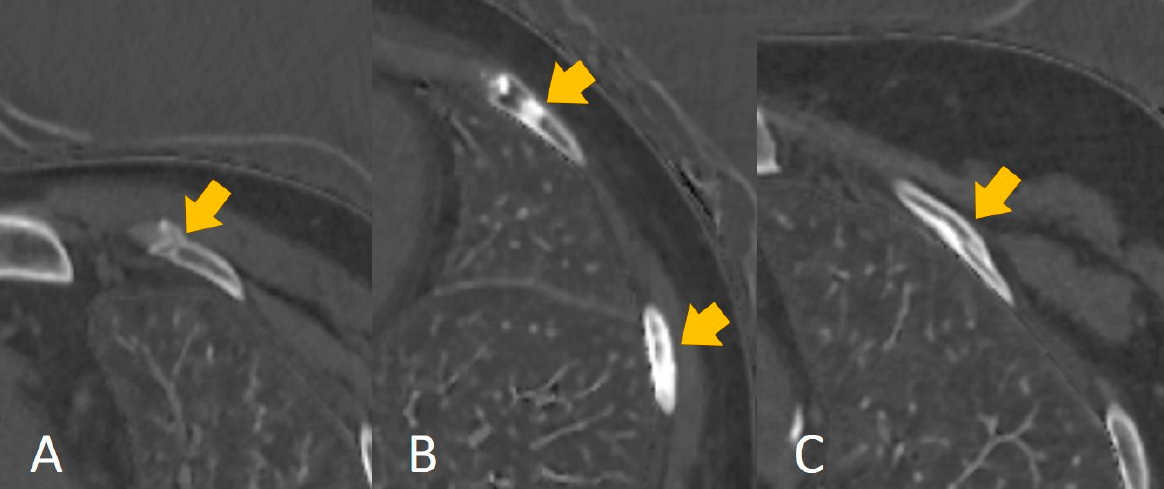
Figure 6. The calcium-based material decomposition images: ( A ) shows the injury time of a rib fracture within 30 days; ( B ) shows the injury time of a rib fracture between 30 and 90 days, and ( C ) shows the injury time of a rib fracture over 90